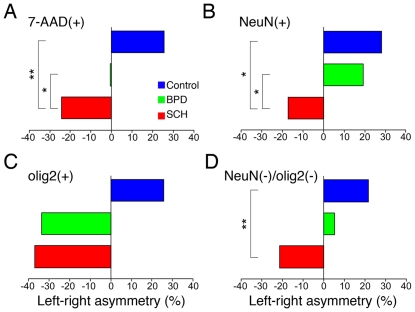
Asymmetry of the nuclei densities in the FPC.(A) 7-AAD(+), (B) NeuN(+), (C) olig2(+), and (D) NeuN(−)/olig2(−) nuclei. Left-right asymmetry rates (%) were calculated using the following formula: (the mean nuclei density in the left hemisphere)/(the mean nuclei density in the right hemisphere) ×100–100 (%). The positive % indicates left-greater-than-right asymmetry in the nuclei densities and the negative % vice versa. * P<0.05, **P<0.01, two-factor factorial ANOVA (diagnostic group×brain hemisphere).